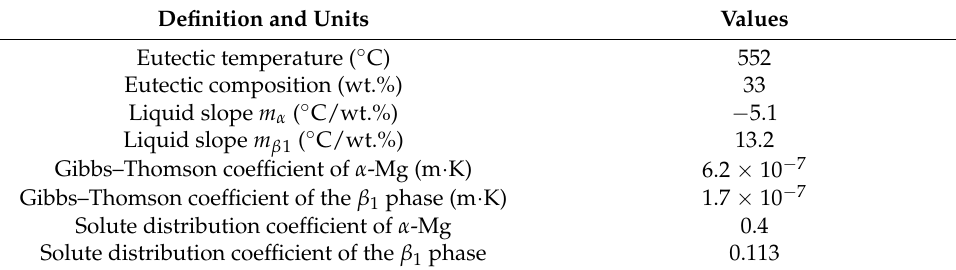
Table 2. Thermophysical parameters of Mg–Nd alloy from Refs